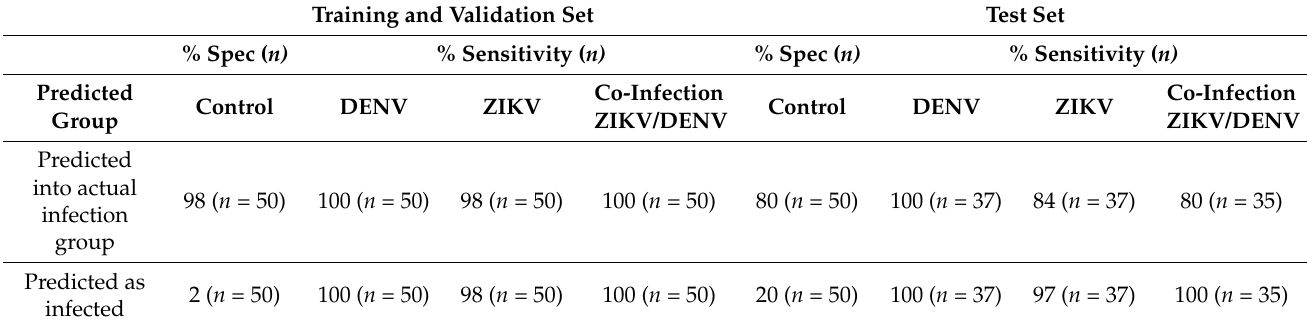
Table 2. Prediction accuracy for Ae. aegypti infection status in training/validation set and test set. Mosquitoes could be infected with either DENV or ZIKV single infection, coinfected with DENV and ZIKV or uninfected